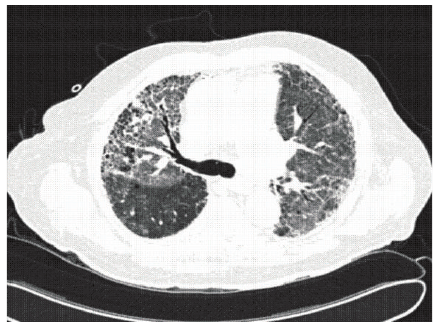
Figure 2: CT angiograph showing no evidence of acute pulmonary thromboembolism but the patient has extensive pulmonary fibrosis.